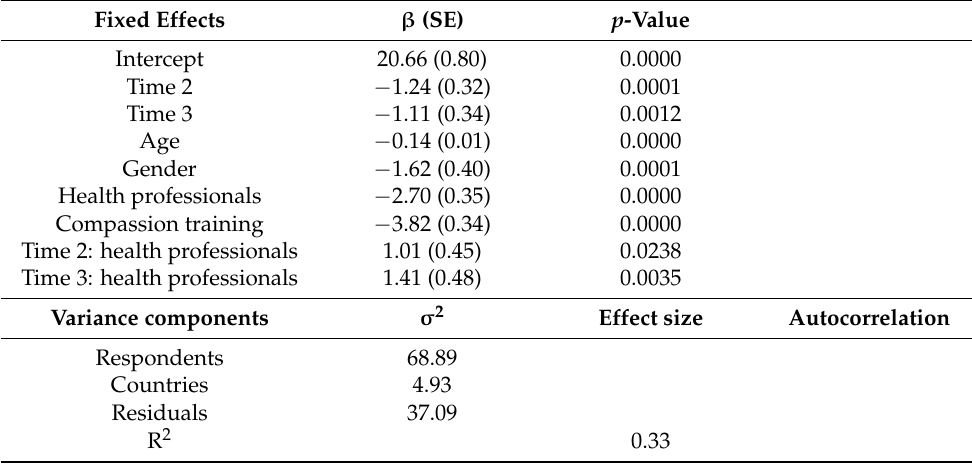
Table 4. Estimates of the final model for fears of